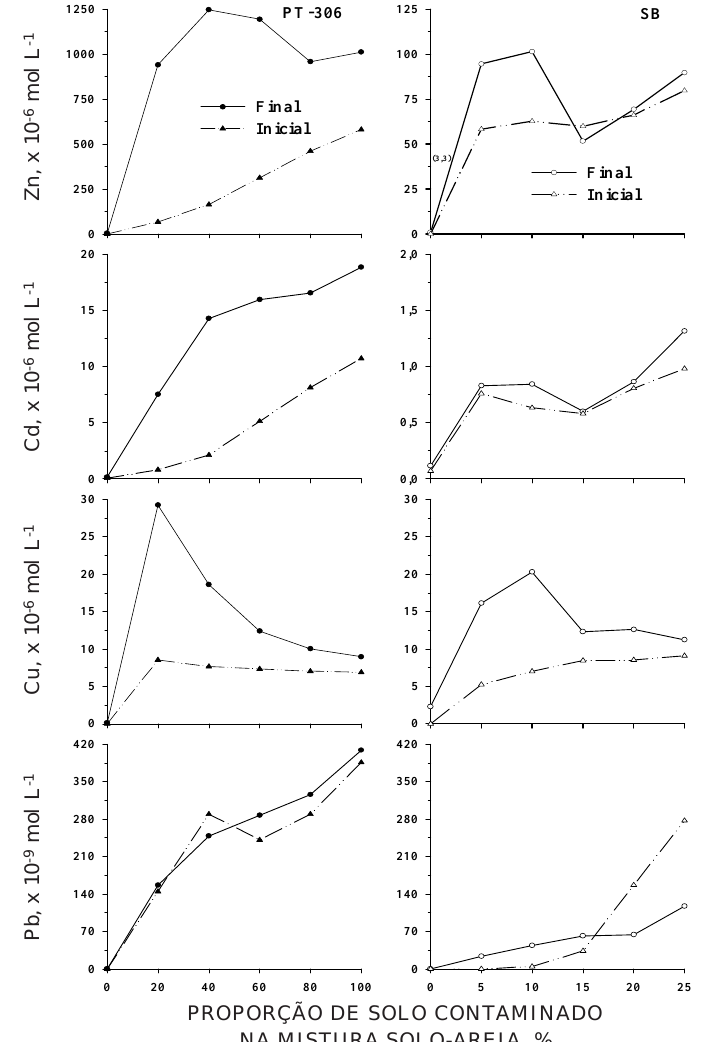
Figura 4. Teores iniciais e finais de metais pesados na solução do meio de cultura (MNM) que continha mistura de solo e areia com diferentes proporções de solo contaminado onde foram crescidos os isolados PT-306 e